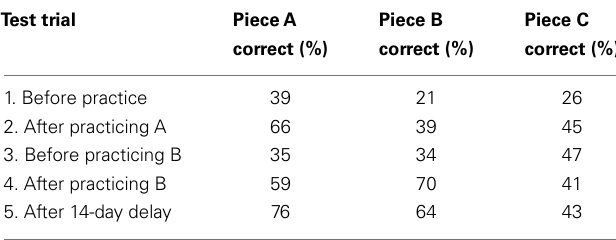
Table 5 | Mean percentages of notes according to piece and test trial